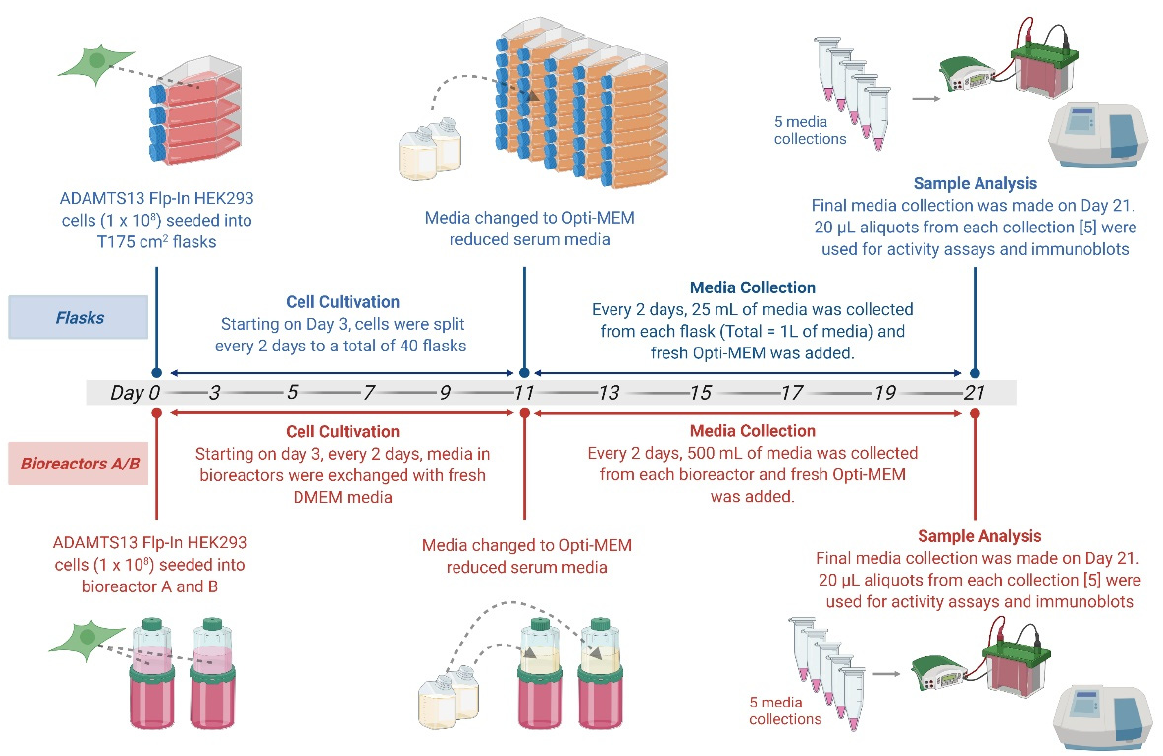
Figure 3. Timeline of bioreactor vs. flask comparison for the cultivation of ADAMTS13 Flp-In HEK293 cells. ADAMTS13 Flp-In HEK293 cells were seeded in parallel within the bioreactor and flask culture systems (1 × 10 8 cells). At 11 days, media in the flasks were changed to Opti-MEM reduced serum media and were collected every 2 days until day 21. On day 21, the final collection (5th) was made, and the media from each collection was used for activity assay and Western Blot analyses. Created with Biorender.com (accessed on 20 December